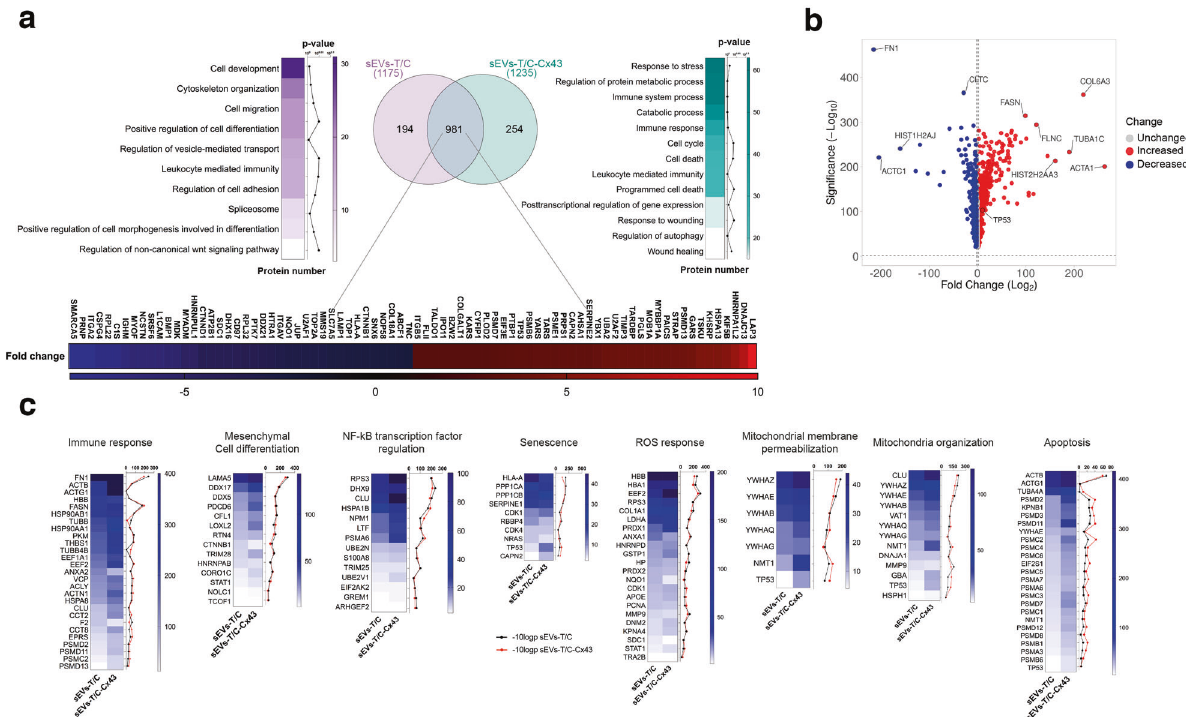
Fig. 5 Proteomic analysis of proteins isolated from sEVs derived from T/C-28a2 chondrocytes with (sEVs-T/C-Cx43) or without (sEVs-T/C) Cx43. a sEVs were isolated by ultracentrifugation and the protein content was analysed by mass spectrometry (TripleTOF 6600 System). Venn diagram showing the number of proteins quanti fi ed in both groups (sEVs-T/C in the left, sEVs-T/C-Cx43 in the right), and the heatmap of upregulated and downregulated proteins in the bottom. b Volcano plot (VolcaNoseR) illustrating the spectral count fold change and its signi fi cance in the common proteins shared by sEVs-T/C and sEVs-T/C-Cx43. Overrepresented proteins in sEVs-T/C-Cx43 are displayed as red dots, while blue dots represent proteins that are increased in the sEVs-T/C group. c Heatmaps representing the spectral count values and the − 10log p -value of proteins involved in NF-kß transcription factor regulation, mitochondrial membrane permeabilization and organization, ROS response, immune response, apoptosis, mesenchymal cell differentiation and senescence. Black lines correspond to − 10log p -value of sEVs-T/C and red lines to − 10log p -value sEVs-T/C-Cx43.